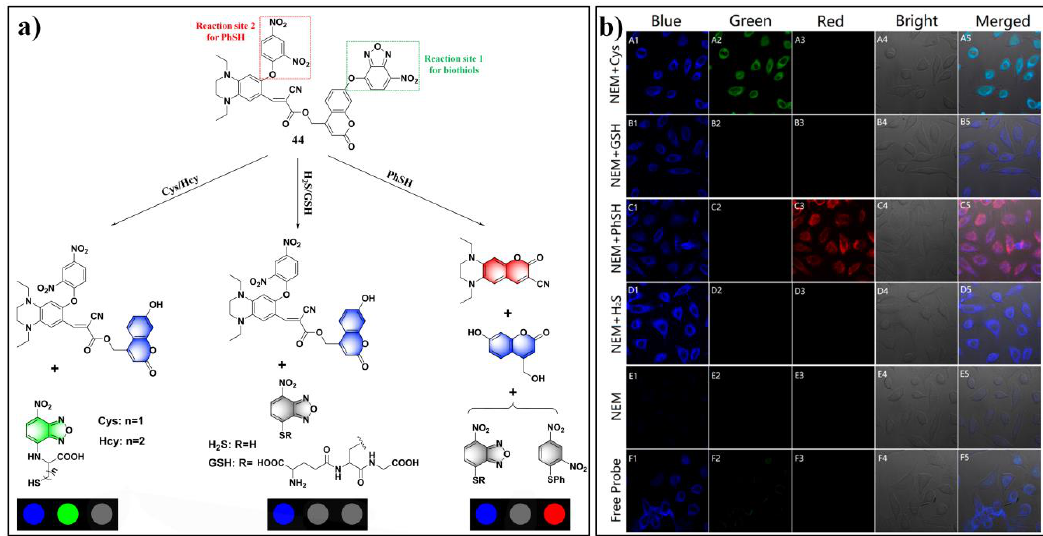
Figure 19. ( a ) Schematic illustration of the sensing mechanism of probe 44 for differentiating cysteine (Cys)/homocysteine (Hcy), glutathione (GSH)/H 2 S, and thiophenol. ( b ) Images of Hela cells incubated with different regents. Reproduced with permission from Reference [112]; copyright American Chemical Society.